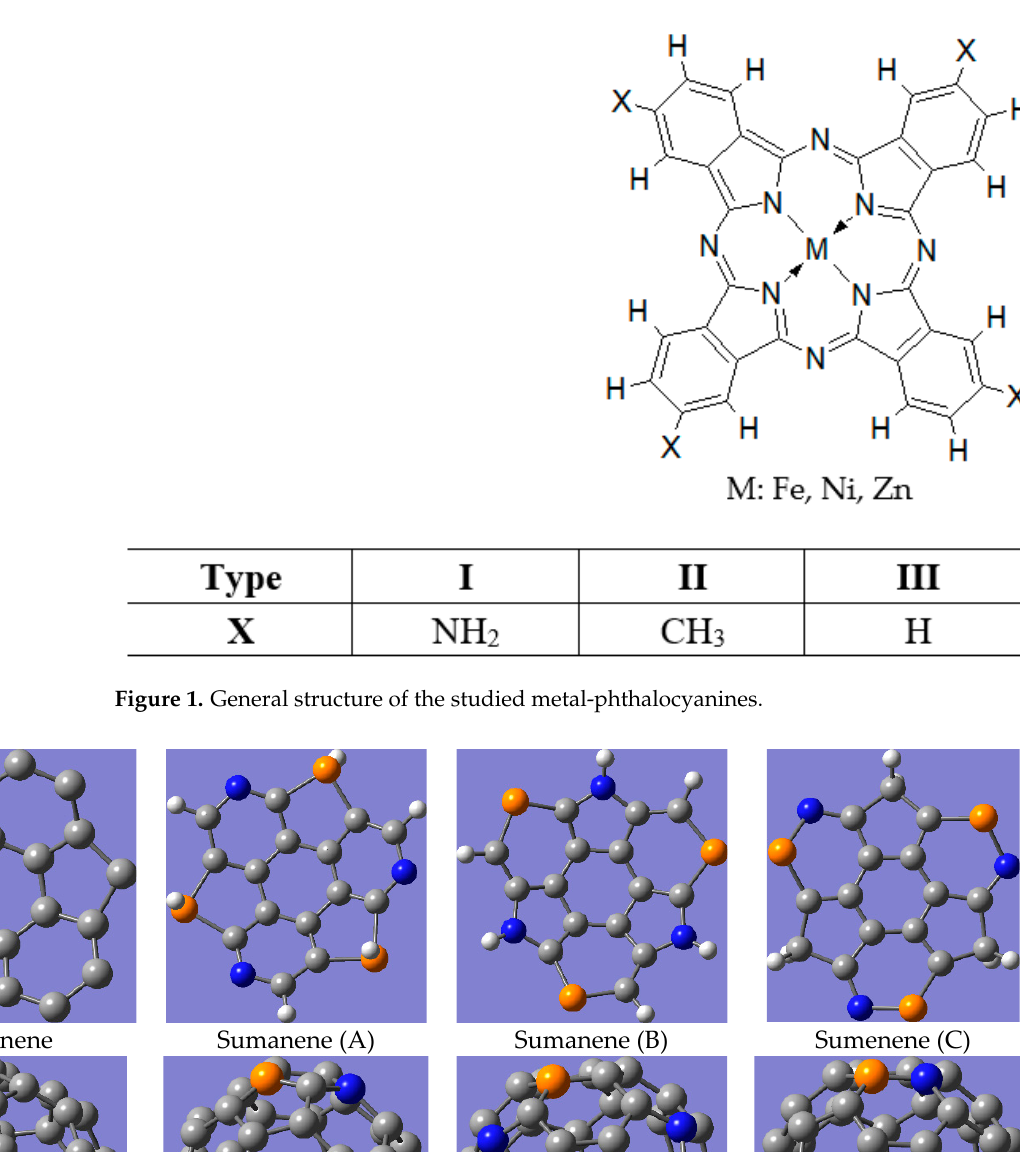
Figure 2. Fullerenes investigated as delivery systems for the metal-phthalocyanins. (C atoms— grey, N atoms—blue, P atoms—orange).